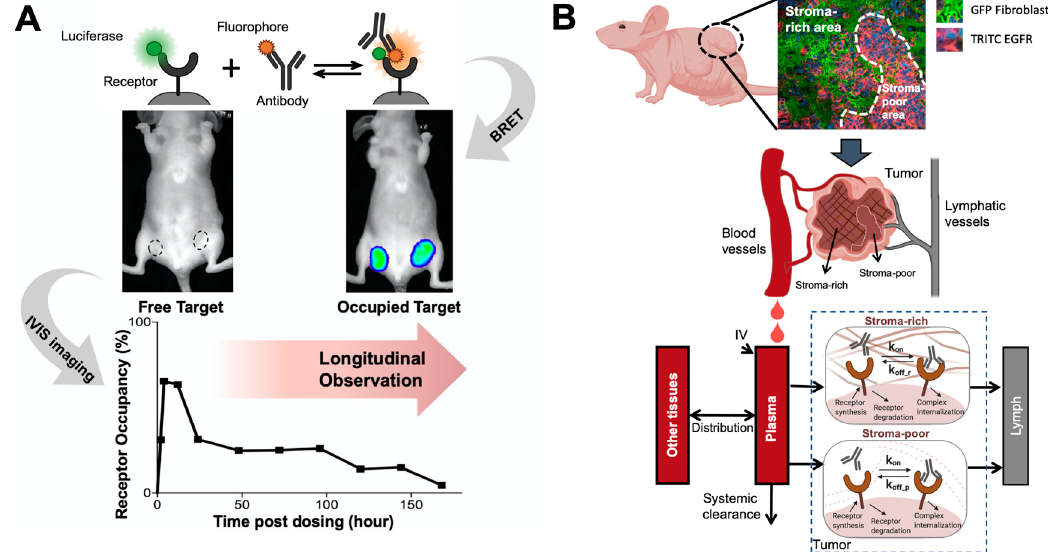
Figure 4. Elucidating antibody-target binding dynamics in the living system. ( A ) A bioluminescence resonance energy transfer (BRET) imaging method continuously and noninvasively monitor antibody-target interactions in the living tumors. A bright luciferase, NanoLuc, was fused to EGFR as the BRET energy donor. When cetuximab binds to EGFR in solid tumors, the distance between stimulated NanoLuc and DY605 (fluorophore) enables the resonance energy transfer from stimulated NanoLuc to DY605-cetuximab. DY605 emissions from living tumors directly visualized the interactions between cetuximab and EGFR (Adapted from abstract graph [193], Cell Press, 2019). ( B ) A spatially-resolved model characterizes antibody-target binding dynamics in living tumors. The tumor is divided into two compartment (the stroma-rich vs. stroma-poor tumor area), and the model assumes antibody binds to its target at different dynamics in two compartment, which well recapitulated the longitudinal imaging data (Adapted from Figure. 2 [194], Nature Research, 2020).